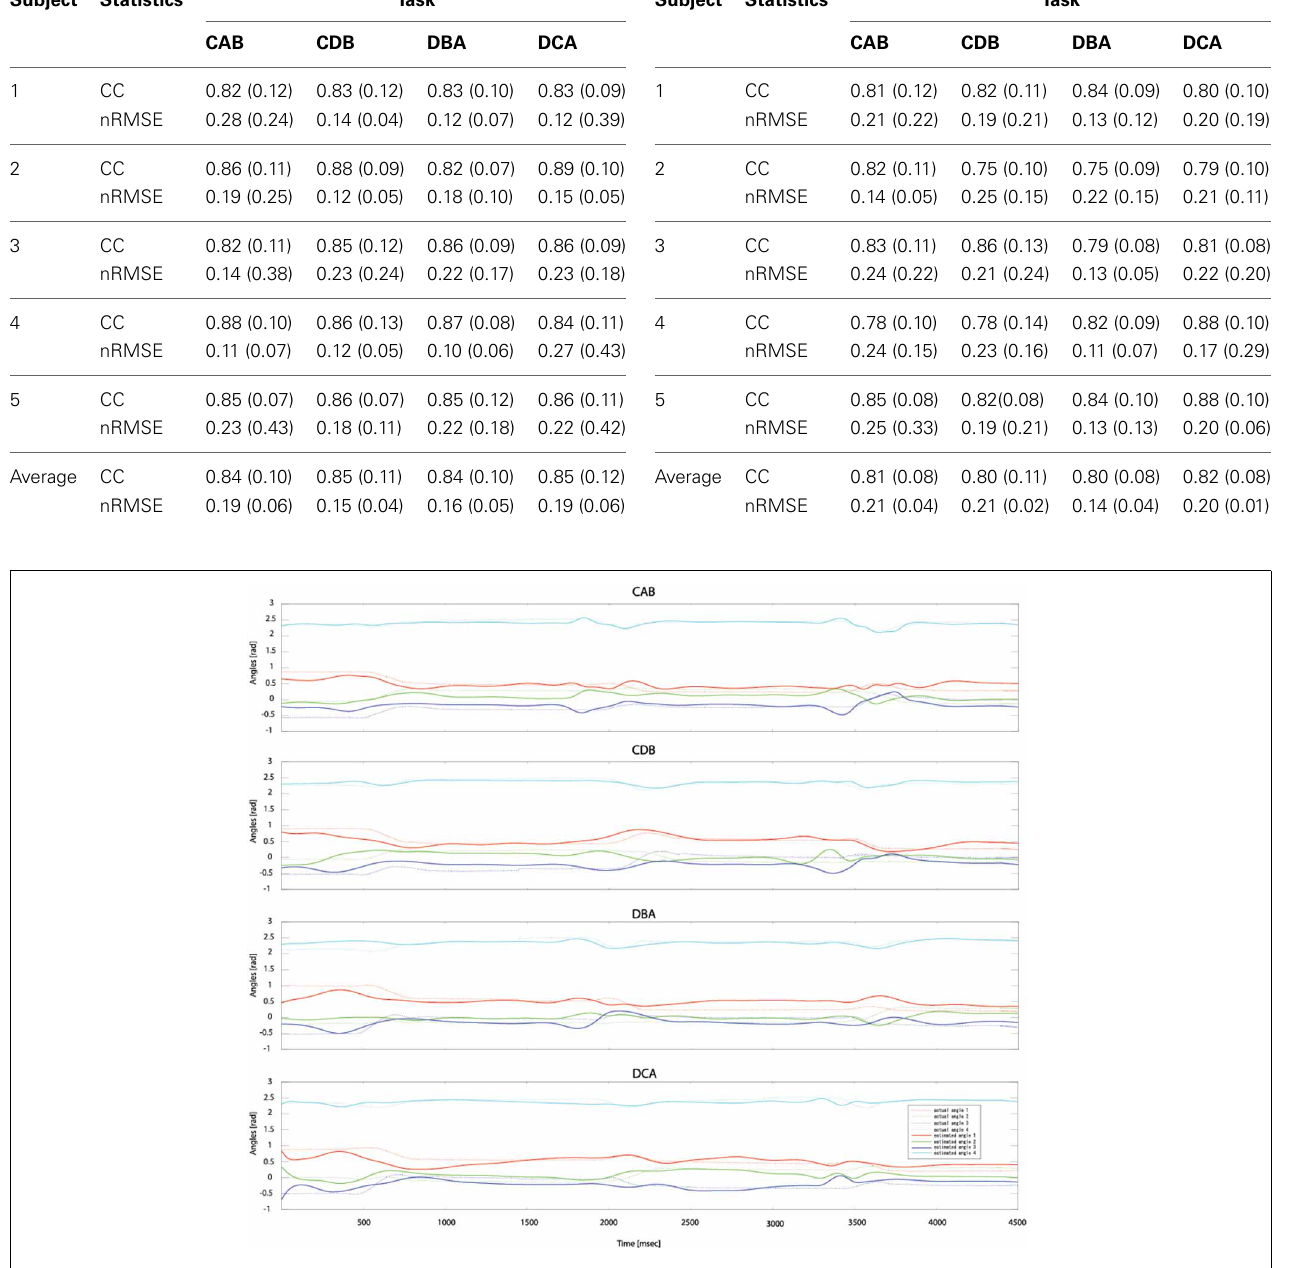
FIGURE 8 | Estimated joint angles from the cortical activities of the primary motor cortex. Dashed lines represent the actual joint angles and solid lines show the estimated joint angles.